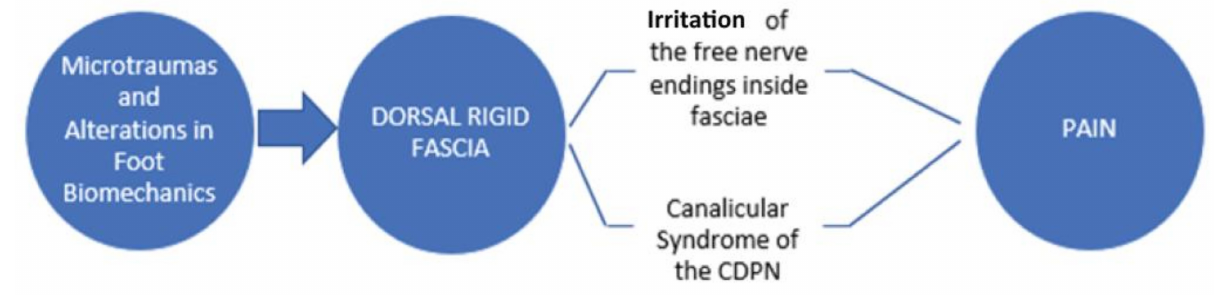
Figure 5. Hypothesis of a role of deep fascia in the pathogenesis of